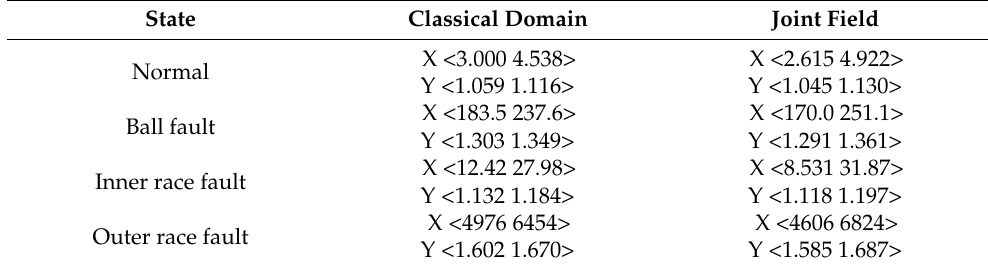
Table 7. Classical Domain and Joint Field When SPOF Diameter = 0.007 in, HP = 3.